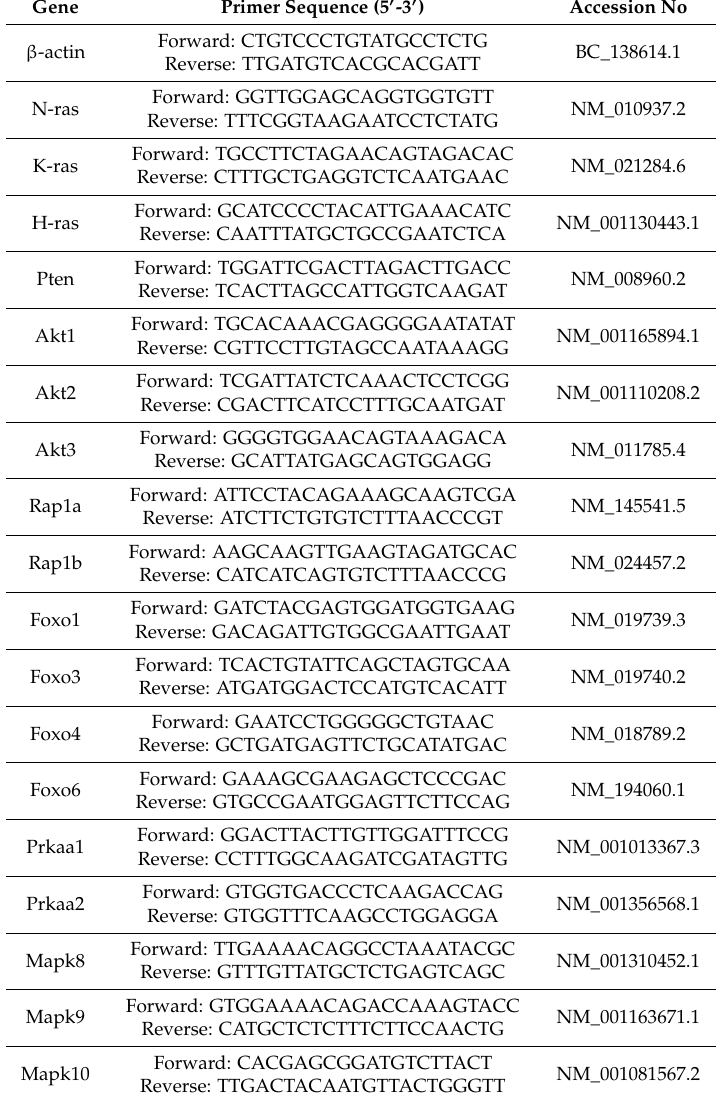
Table 2. Primer sequences of mRNA used in this study for quantitative real-time RT-PCR. Gene Primer Sequence (5 (cid:48) -3 (cid:48)